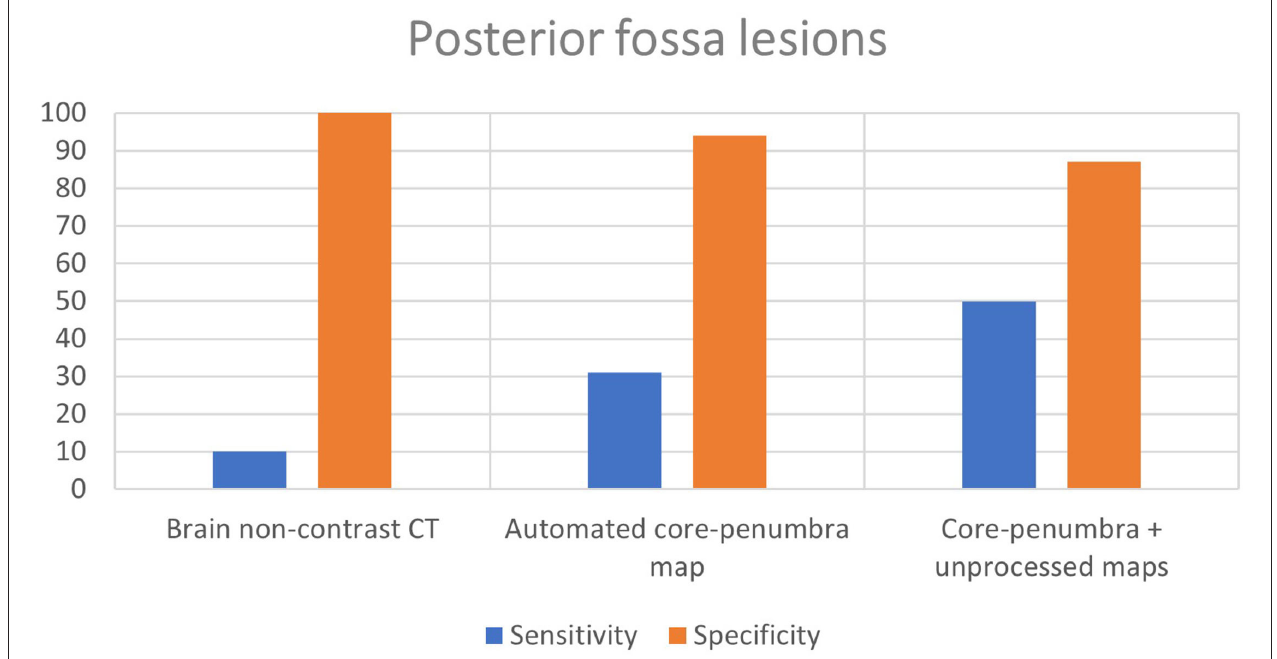
FIGURE 1 | Mean sensitivity and specificity for detection of posterior fossa lesions of different imaging modalities.